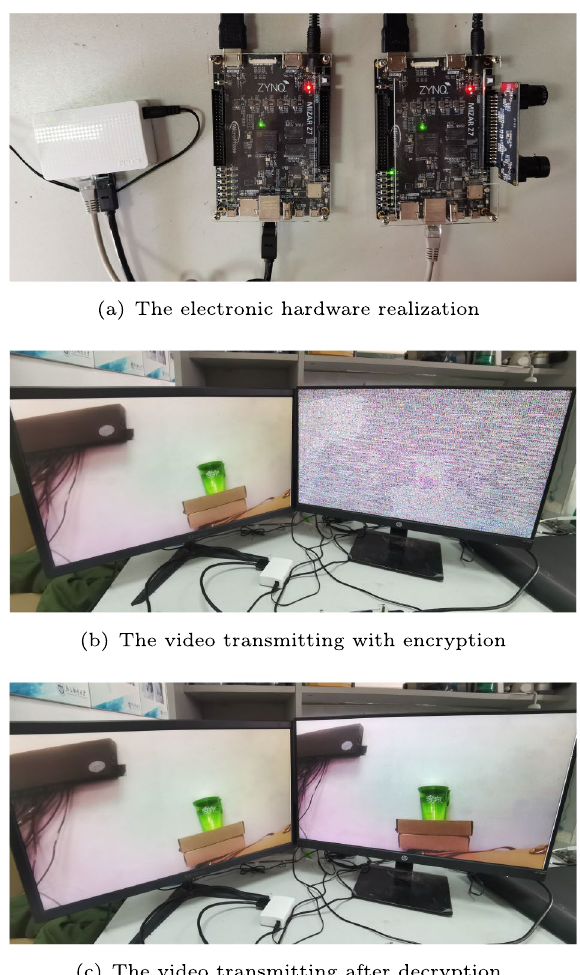
Fig. 11 Experimental results based on the CSTDR-based secure communication